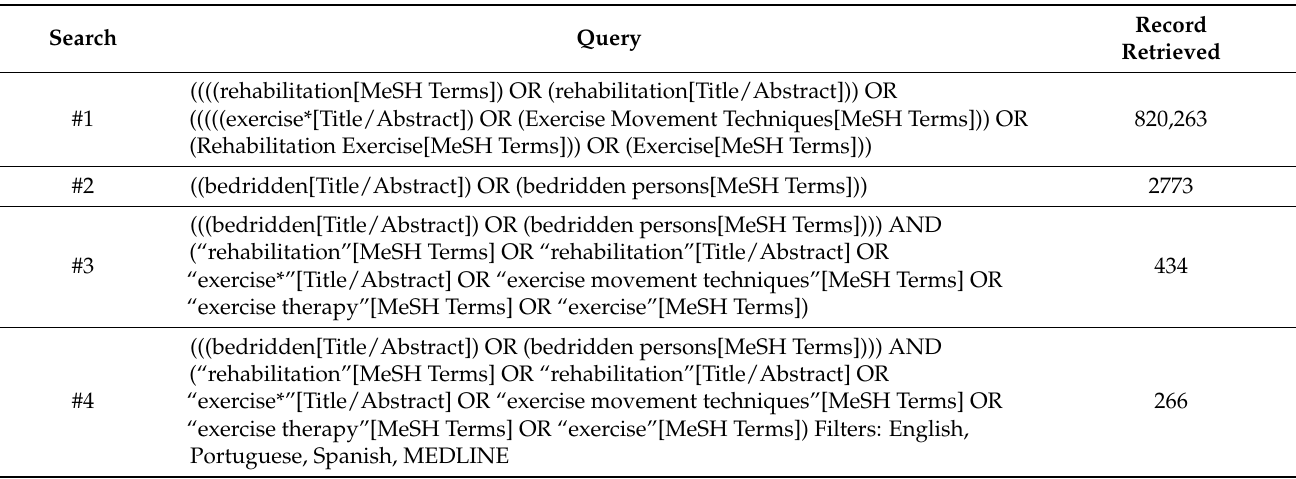
Table 1. Search strategy for MEDLINE (PubMed). The search was conducted on 7 October 2021.